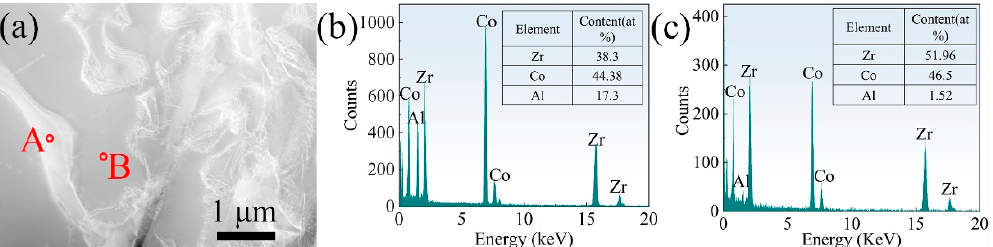
Figure 8. TEM images of Zr 46.5 Co 46.5 Al 7 alloys: ( a ) microstructure of the as-cast alloy; ( b ) EDS pattern of point A; ( c ) EDS pattern of point B.